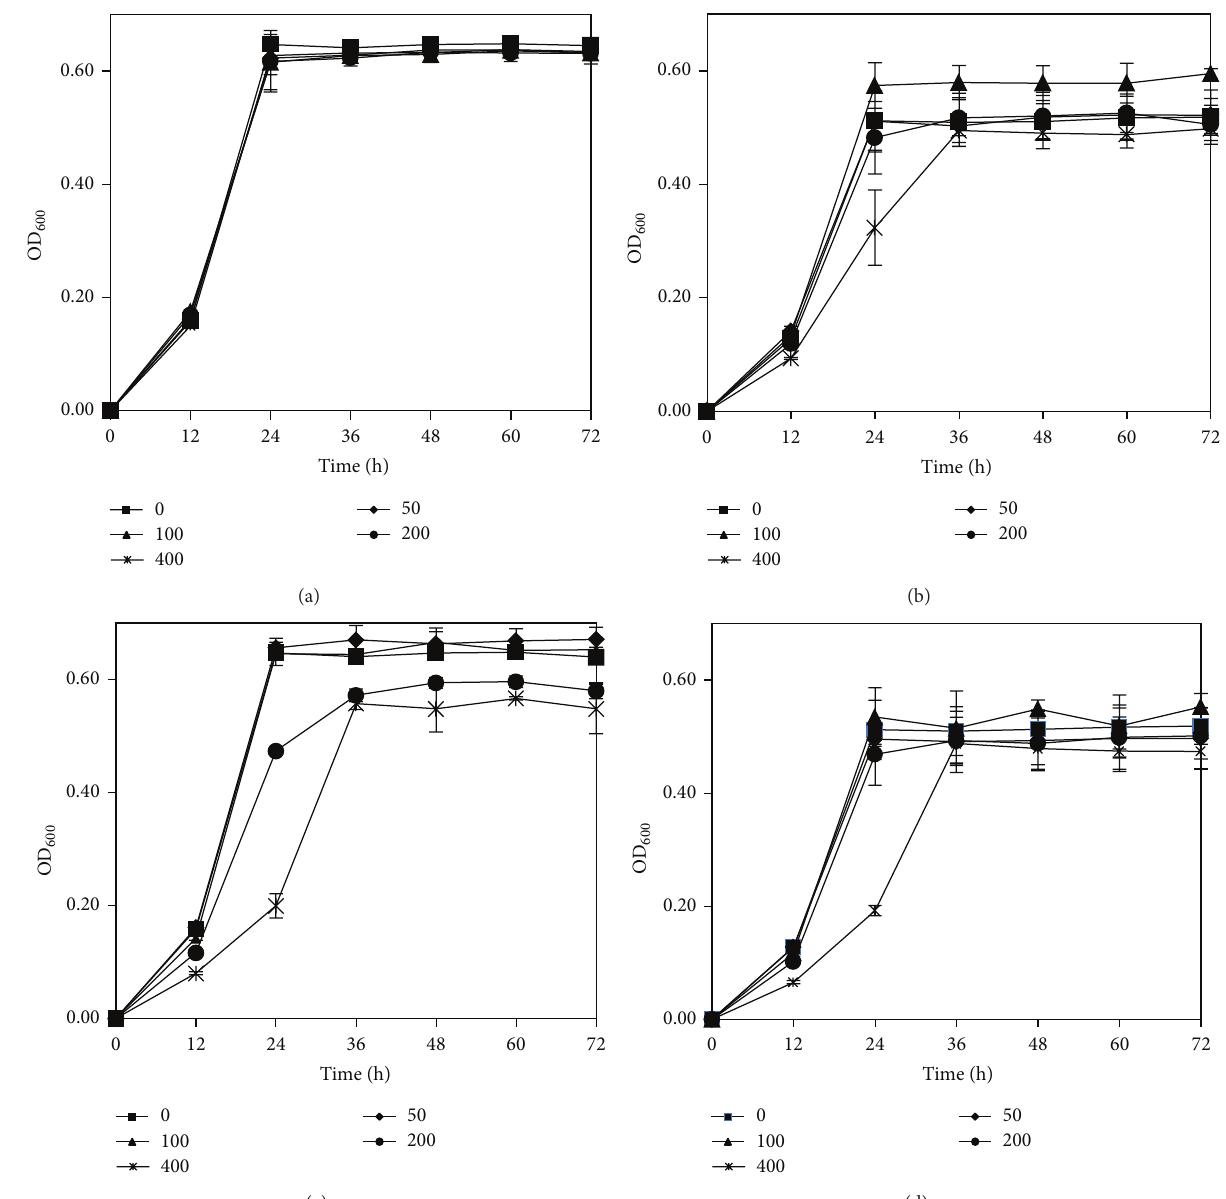
Figure 3: Bacterial growth of strain FD-1 in cometabolism systems. 4-FA served as the first-class substrate (also named growth substrate), while 2-FA (a), 2,4-DFA (b), 3,4-DFA (c), and 2,3,4-TFA (d) were the secondary substrates. Unit for legends is